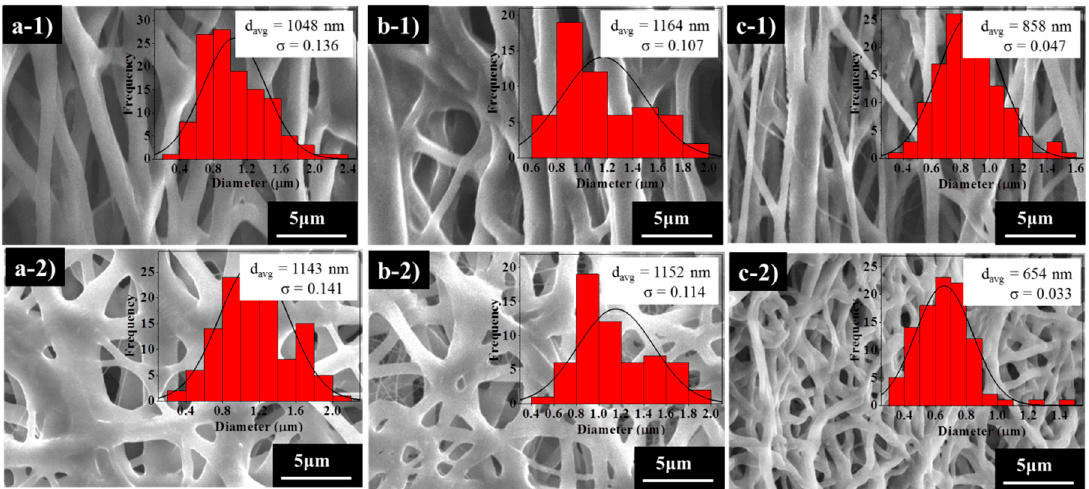
Figure 7. The SEM images of the nanofibres’ structure during the deformation and after recovery: ( a-1 , a-2 ) PCL 6 –PDMS 4 ; ( b-1 , b-2 ) PCL 7 –PDMS 3 ; ( c-1 , c-2 ) PCL 8 –PDMS 2 .